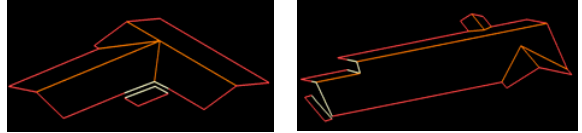
Figure 7: Generated L-Shaped roof structure with a height jump (left) and Complex connected roof (right): red – outer bounds, orange – ridge-lines, white –